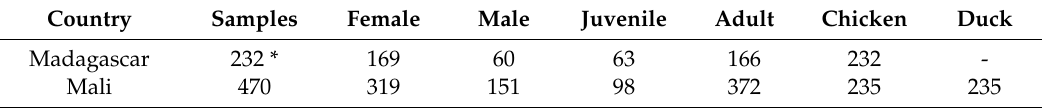
Table 1. Number of domestic birds sampled by sex, age and species in Madagascar and Mali. Country Samples